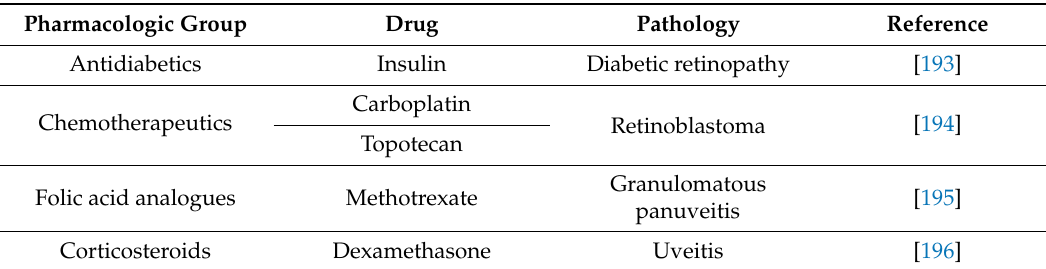
Table 6. Summary of subconjunctival administered drugs for the treatment of posterior segment ocular